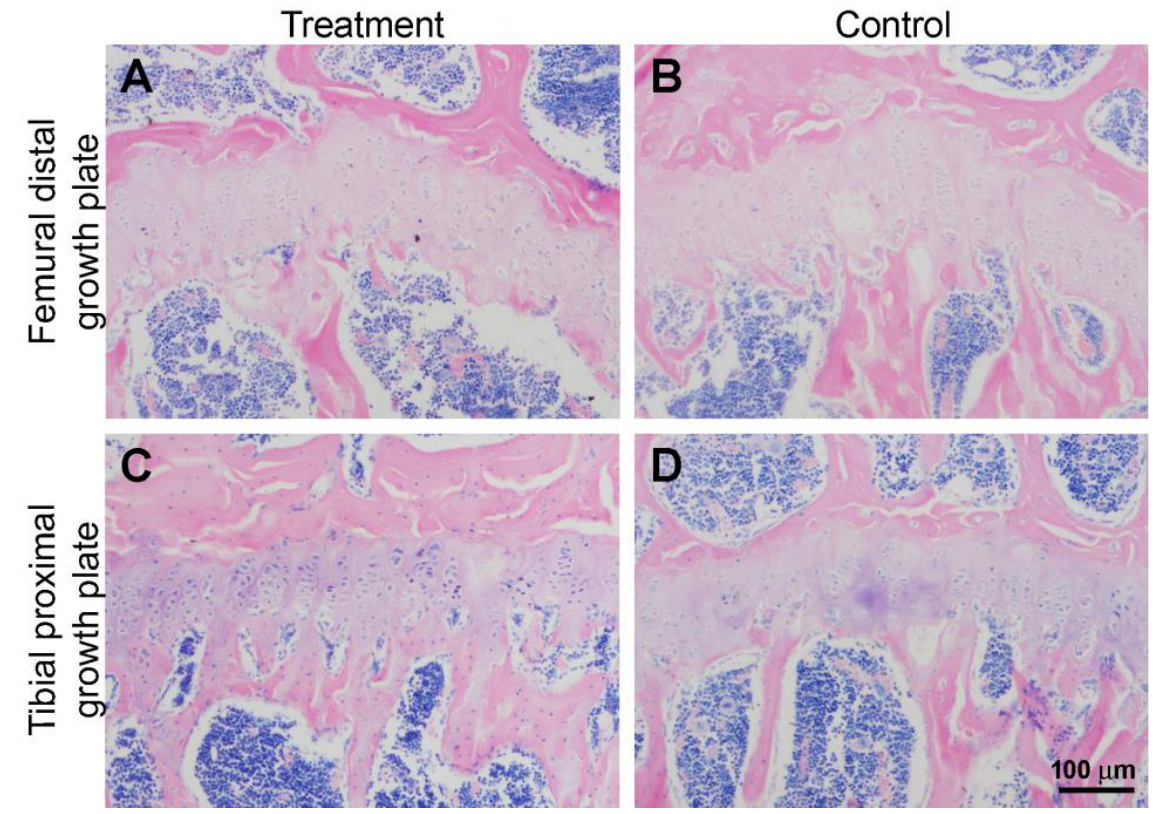
Figure 5. Representative histological sections of the growth plate in the femoral distal metaphysis ( A , B ) and tibial proximal metaphysis ( C , D ) of treatment and control groups. Histomorphometric results concerning the thickness of the growth plate are shown in Table 3; no significant differences were found between the treatment and control groups. Table 3. Thickness ( µ m) of growth plate measured in femoral distal metaphysis and tibial proximal metaphysis sections. All values are expressed as mean ± S.D. (n = 7 for each group).